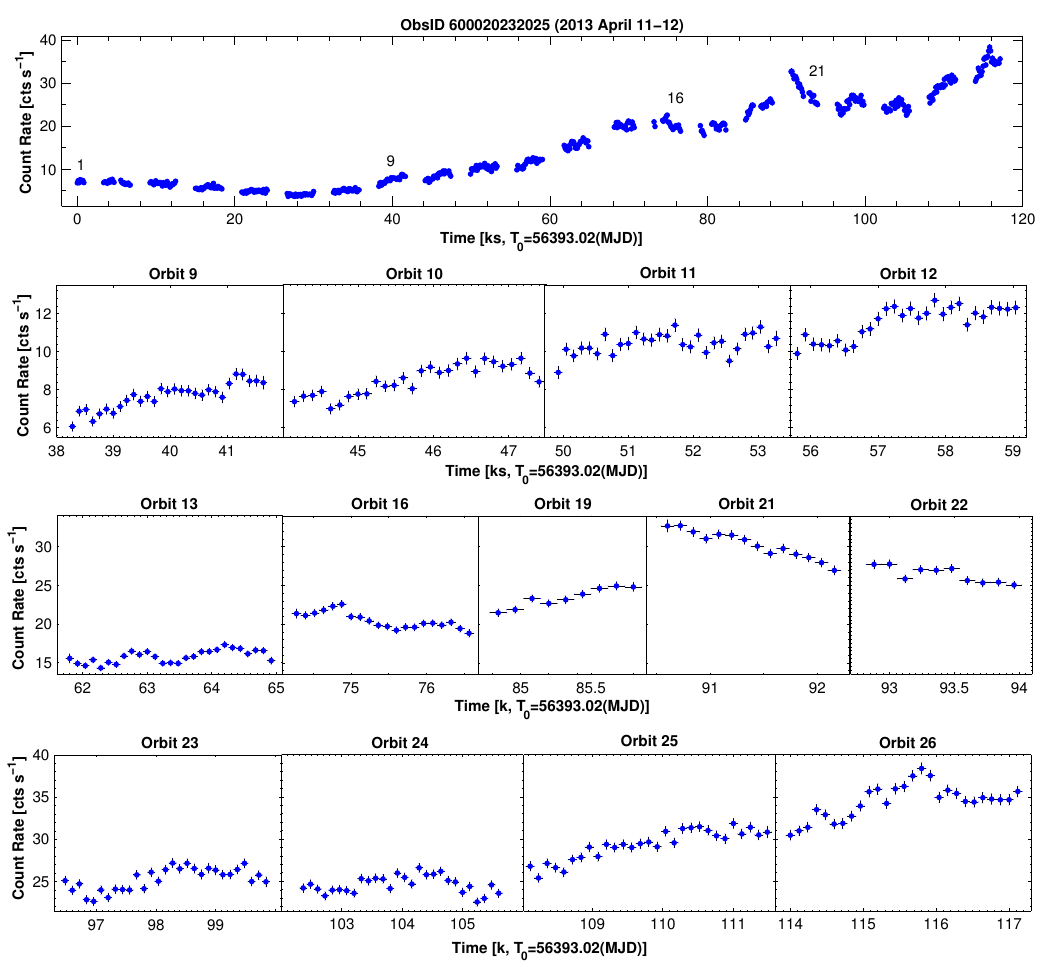
Figure 4. The extended NuSTAR observation of Mrk421 on 11–12 June 2012 (reproduced from Kapanadze et al. 24).